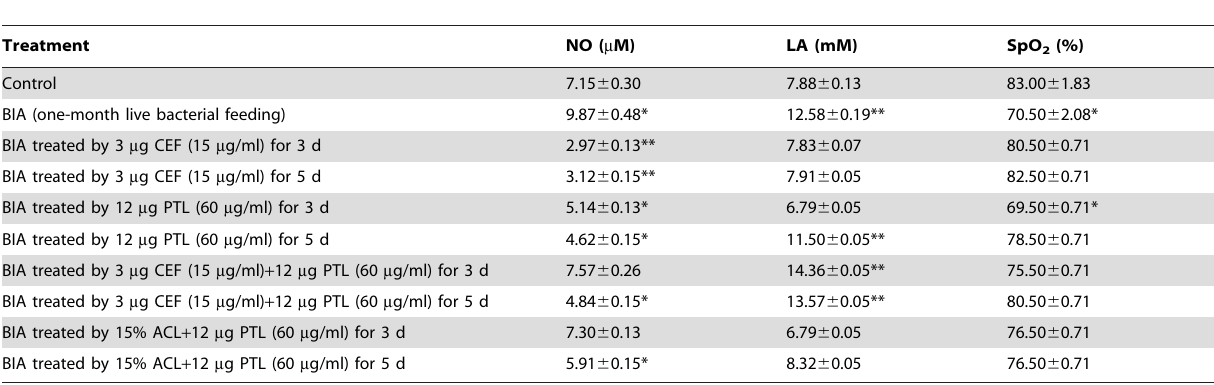
Table 5. Measurement of hypoxic parameters for evaluation of cefotaxime on bacteria fed mice ( n = 4).